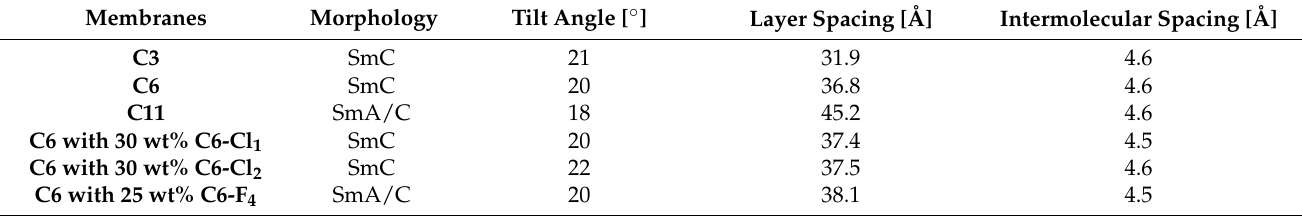
Table 3. Morphology, tilt angle, layer spacing and intermolecular spacing of the fabricated LC